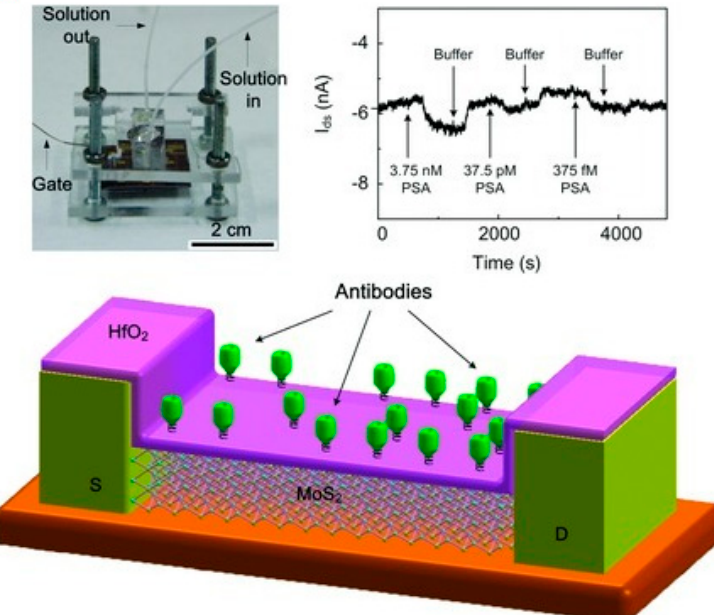
Figure 12. Label-free sensing tool based on molybdenum disulfide (MoS 2 ) nanosheet field-effect transistor, in which antibodies against prostate-specific antigens (PSA) are immobilized on the metal surface of the gate, achieving high degrees of sensitivity. Reproduced with permission from reference [243].